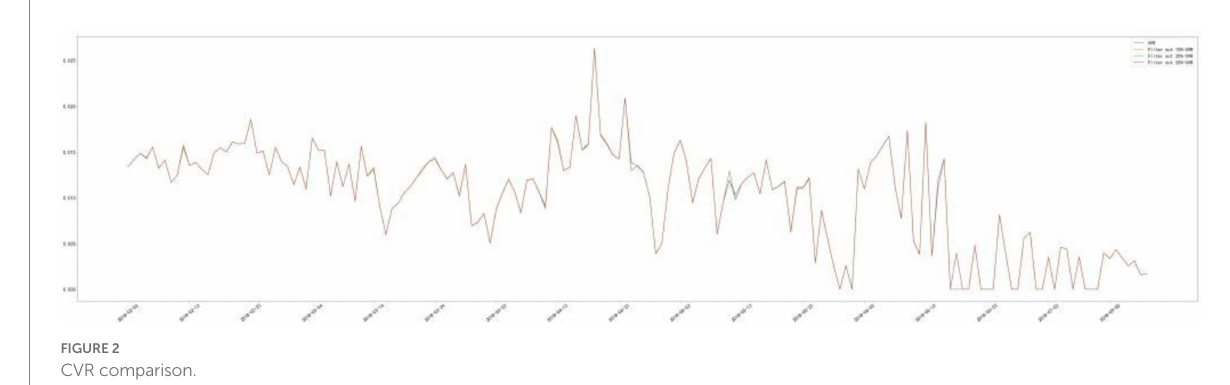
FIGURE 2 CVR comparison.